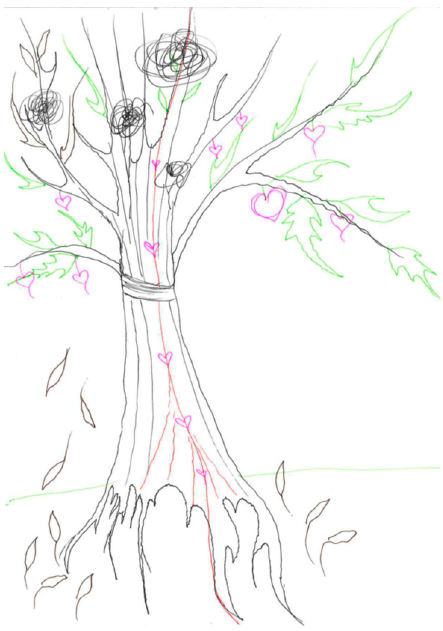
Figure 6. Ava’s Figure 6. Ava’s drawing.